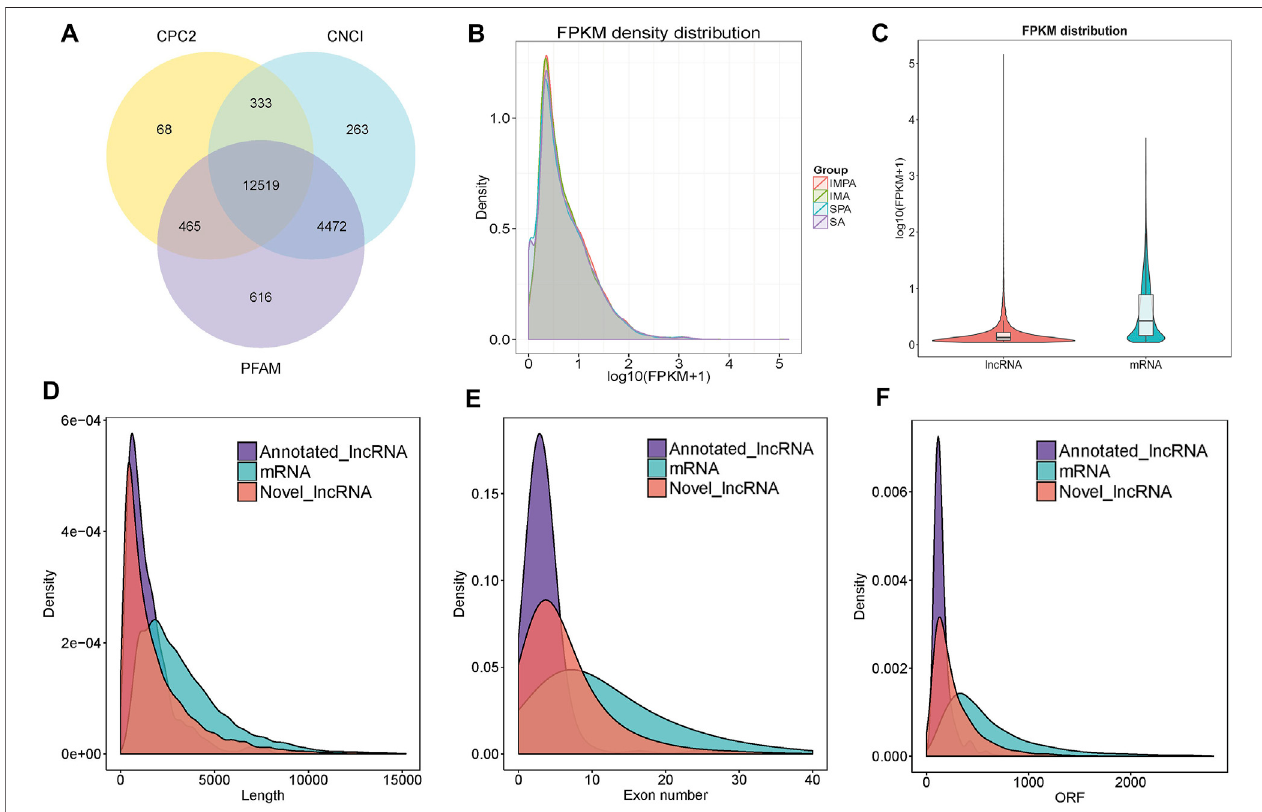
FIGURE 2 | Identi fi cation and characterization of lncRNAs in goat, Capra hircus . (A) Venn diagrams of coding potential analysis by using stringent criteria. Three tools (CPC2, CNCI and PFAM) were employed to analyze the coding potential of lncRNAs. Those simultaneously shared by three analytical tools were designated as candidatelncRNAsandusedinsubsequentanalysis. (B) VolcanicmapsofdifferentiallyexpressedRNA.TheexpressionlevelsofmRNAsandlncRNAswereindicatedby log10 (FPKM +1). (C) LncRNA, mRNA expression violin graph. The horizontal coordinate is the molecular type, the vertical coordinate is log10 (FPKM+1) and the width of each violin plot re fl ects the number of points at that expression level. (D) Length distribution of mRNAs and lncRNAs, unit of the length is bp. (E) Distribution of exon number in the mRNAs and lncRNAs. (F) Open reading frame (ORF) length distribution for mRNAs and lncRNAs.